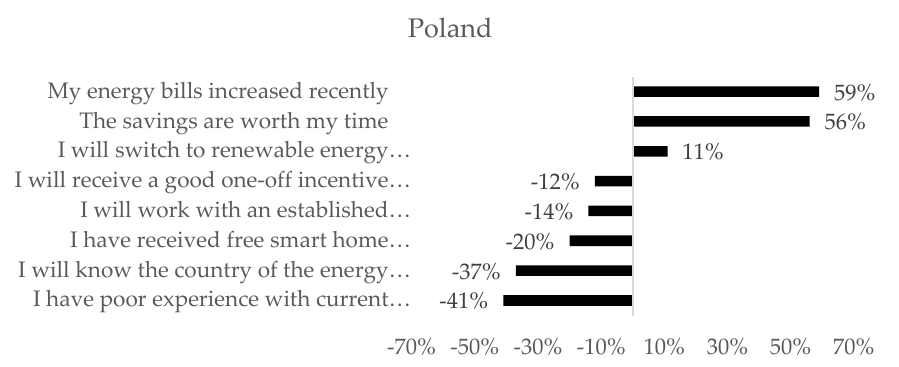
Figure 7. Utility attributes for various energy provider reasons in Poland . Source: own study.